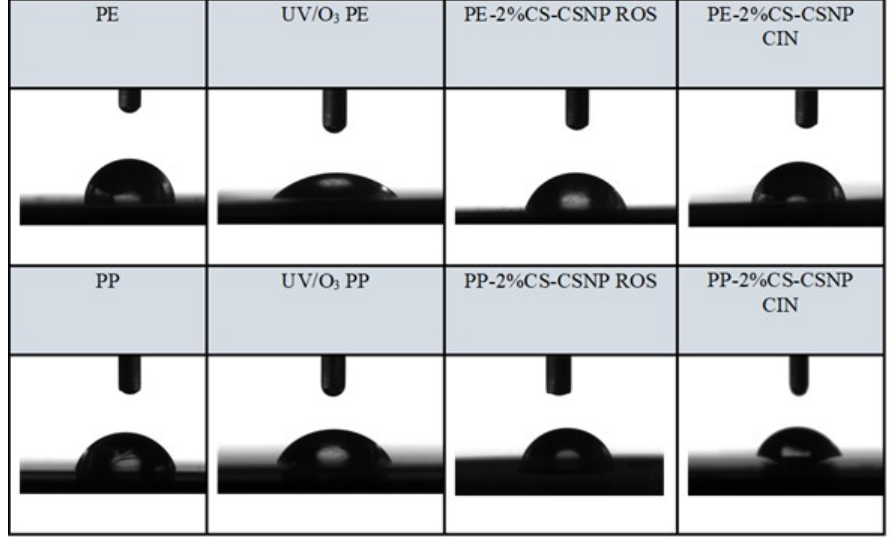
Figure 4. Static contact angle (SCA) of foils functionalized by cinnamon extract (CIN) and rosemary extract (ROS) in combination with chitosan.